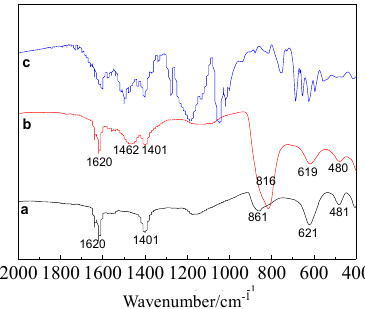
Figure 6 . UV-Vis spectra of the initial Acid Red B solution(a) and the filtrate after degrading reaction (b).